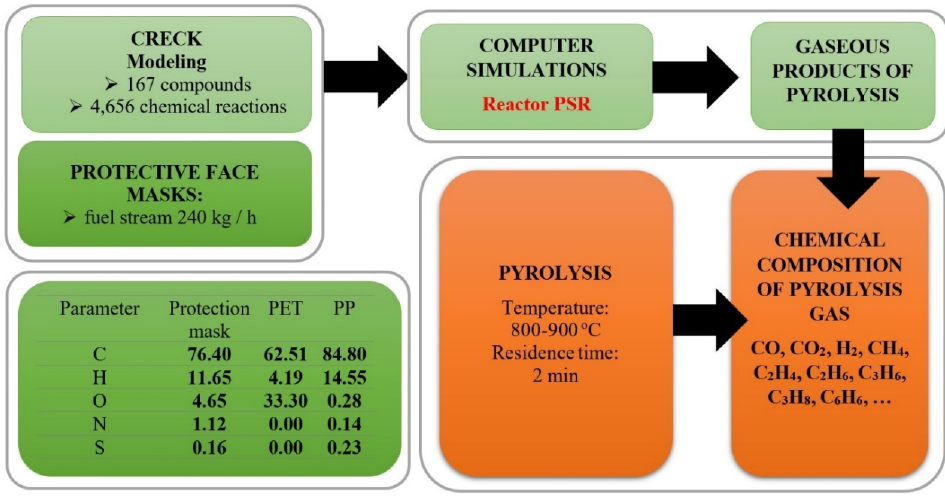
Figure 4. Scheme of calculation